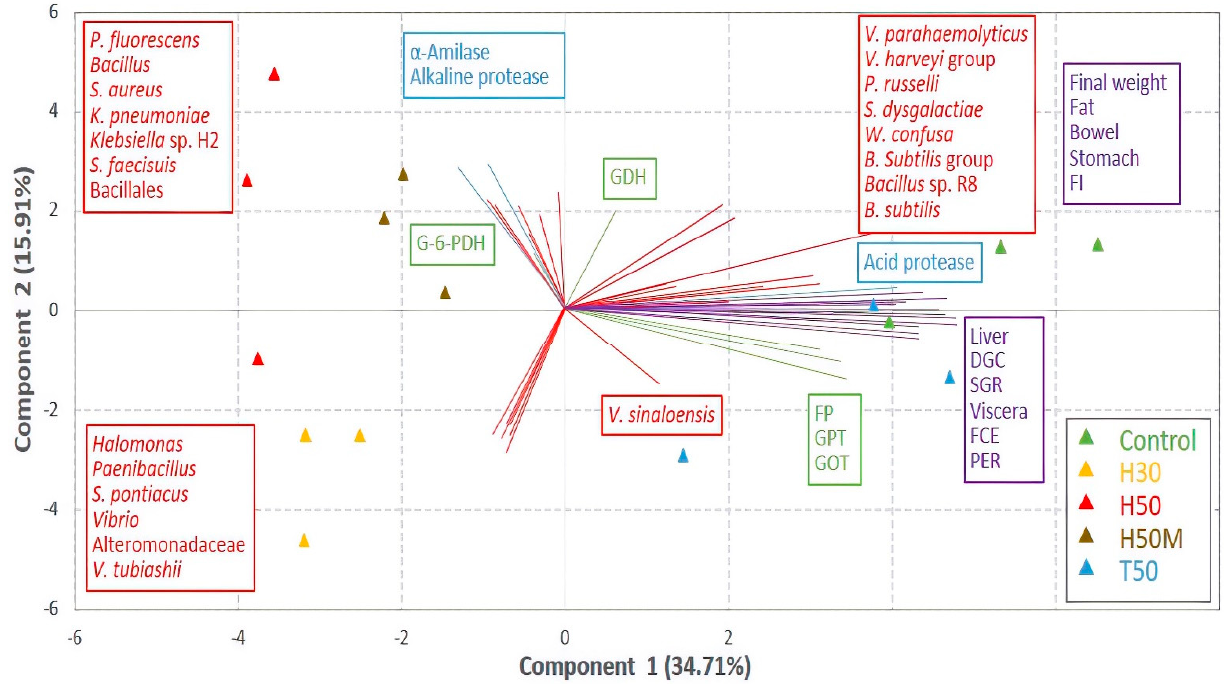
Figure 4. Principal component analysis biplot showing grouping of treatments and relationships amongst variables as influenced by treatments. Metabolic enzymes are depicted in green, digestive enzymes in blue, biometric parameters in violet, and microorganisms in red.